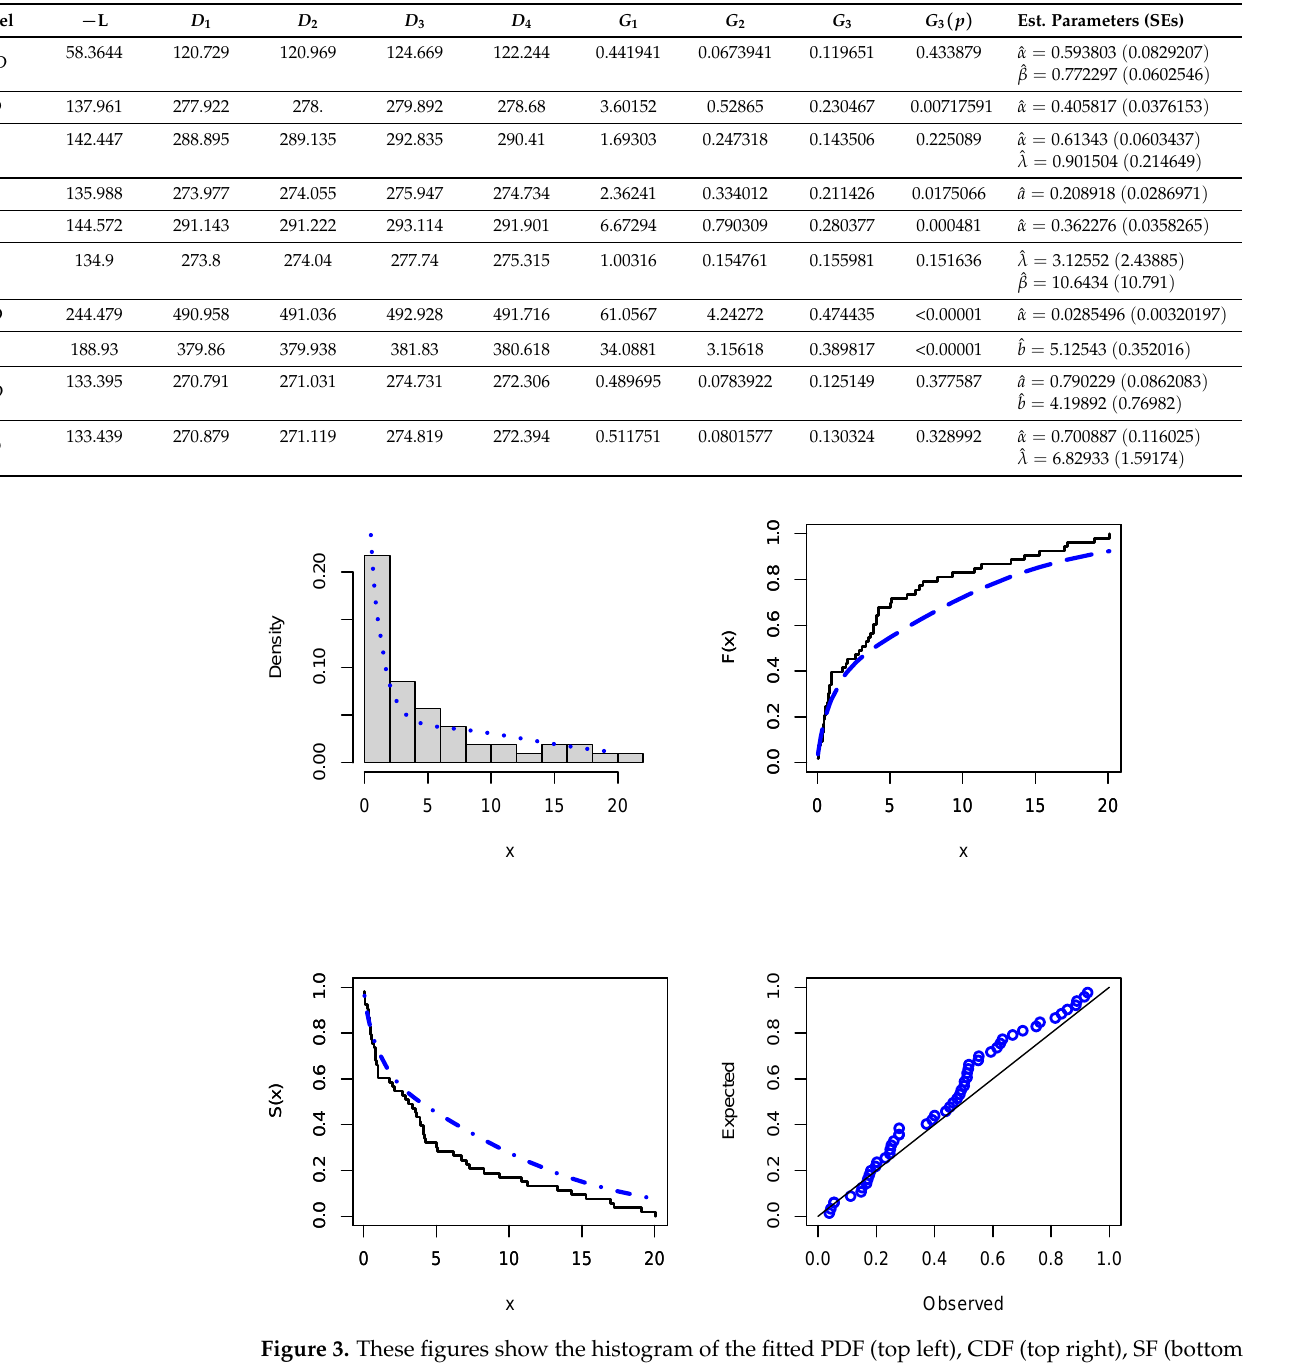
Table 7. Numerical values for analyzing the COVID-19 real data set.